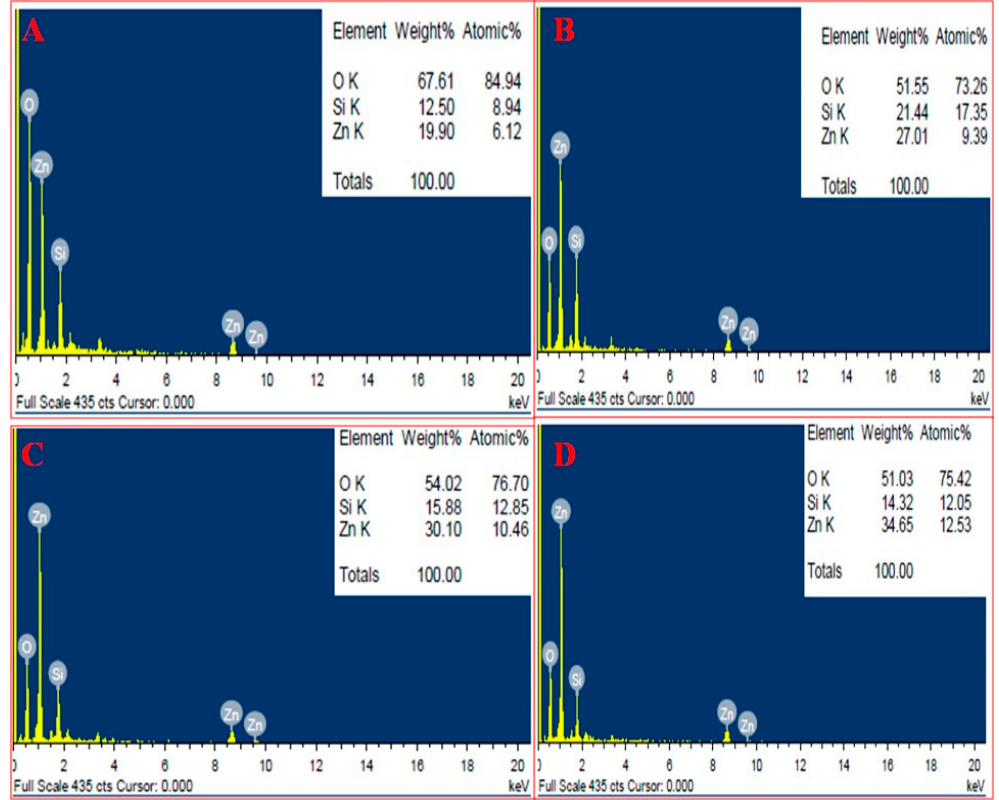
Figure 4. EDAX of BM-ZnO NPs at different concentration of extract. ( A ) 10 mL extract, ( B ) 20 mL extract, ( C ) 30 mL extract, and ( D ) 40 mL extract.